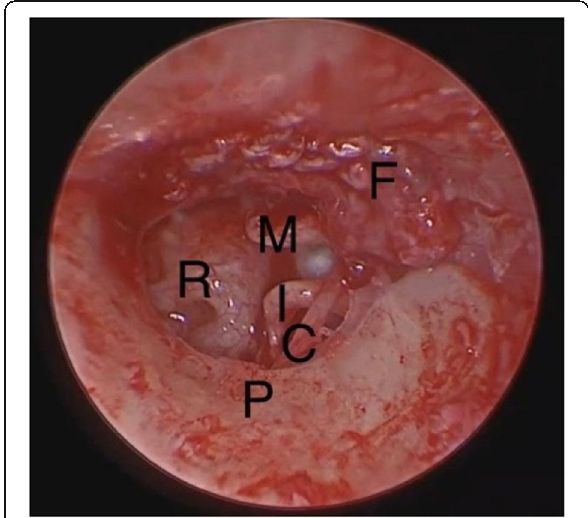
Fig. 2 Endoscopic view of middle ear structures. P, posterior meatal wall; C, chorda tympani; I, incus; R, round window; M, malleus; F, tympanomeatal flap